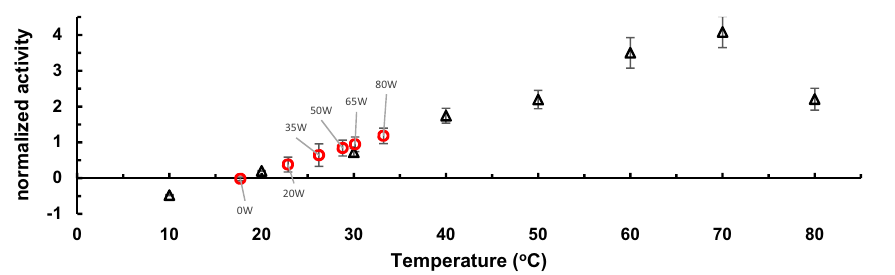
Figure 3. Plot of normalized activity of thermolysin as a function of temperature (black triangles) vs applied power (red circles). The zero point on the activity axis was set to the temperature of the solenoid without an RF field on. Error bars are the uncertainty from the slope of the linear fit. The power study and linear fit used to predict temperature of a given applied power can be seen in SI Fig.